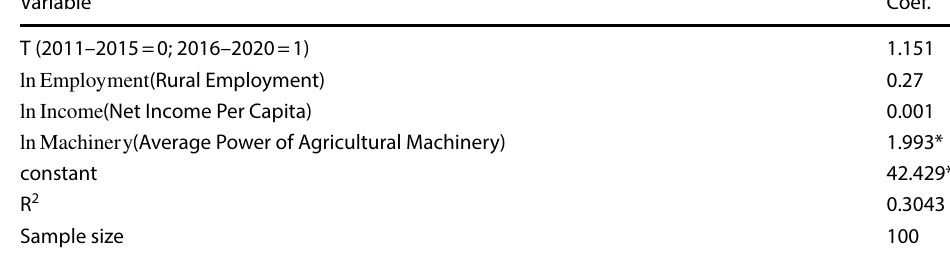
Table 8 Regression results of agricultural GHG emissions in Hubei Province based on the fixed effects model